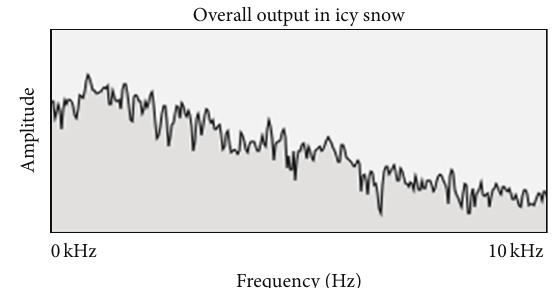
Figure 17: Spectrogram showing a snapshot of the overall output in very icy